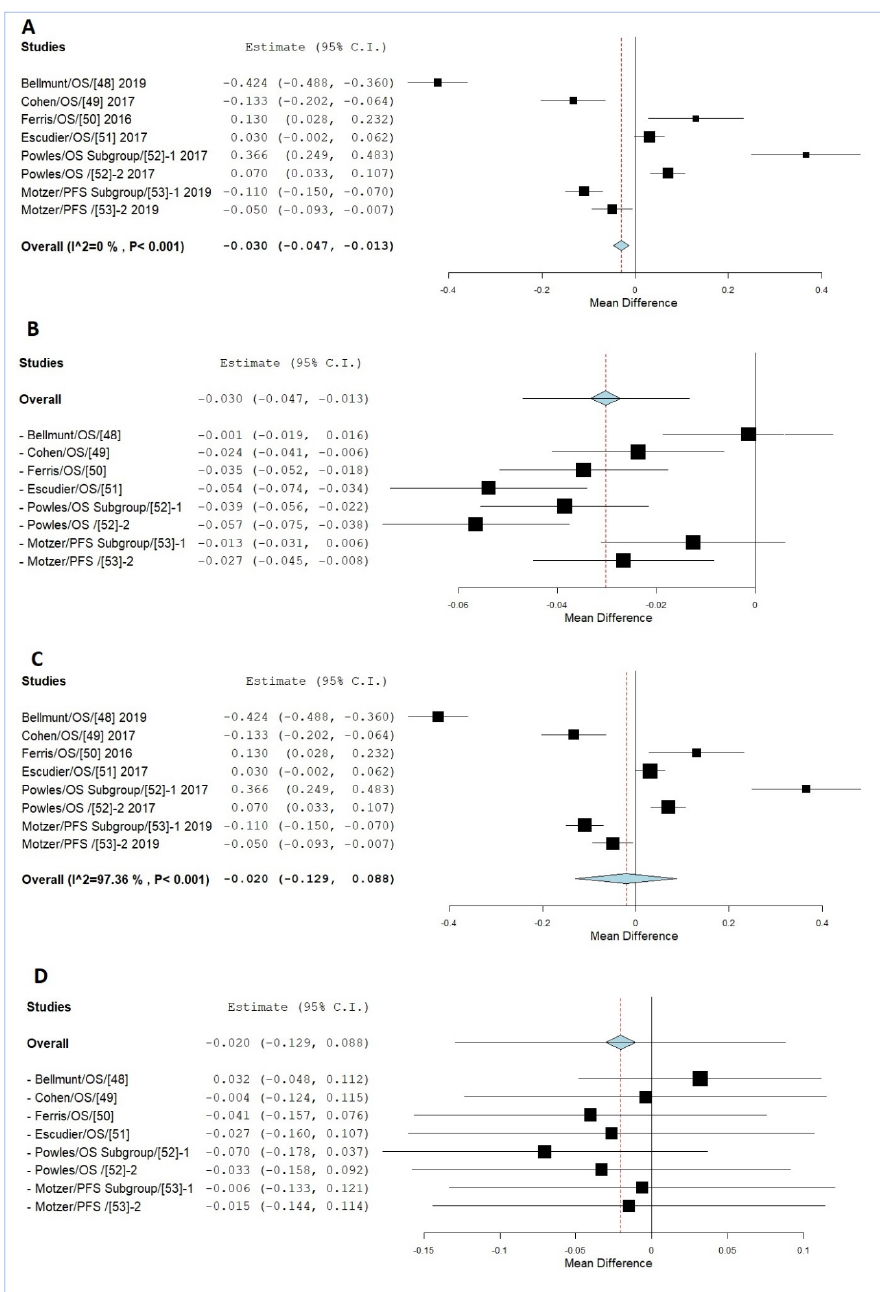
Figure 4. The results indicated that smokers responded better than non-smokers in other cancers. ( A ) Response to treatment by patients of different cancers (FE). ( B ) Response to treatment by patients of different cancers by the FE leave-one-out model. ( C ) Response to treatment by patients of different cancers by the RE model. ( D ) Response to treatment by patients of different cancers by the RE leave-one-out